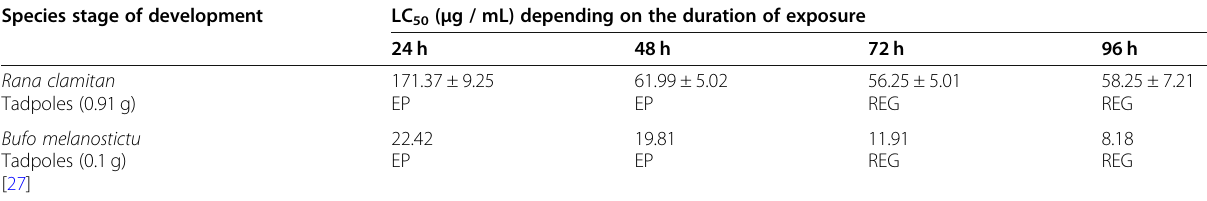
Table 3 Lethal concentration (LC 5O ) of aqueous extract of Guibourtia tessmanii for green frog tadpoles ( Rana clamitans ) Species stage of development Rana clamitan Tadpoles (0.91